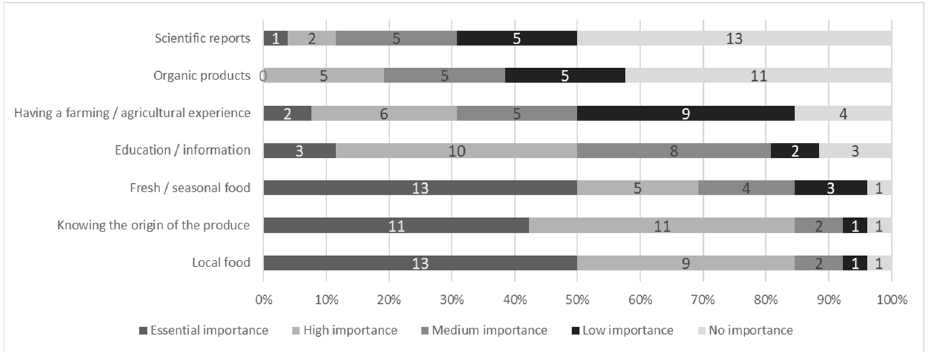
Figure 9. Levels of importance of different client expectations.